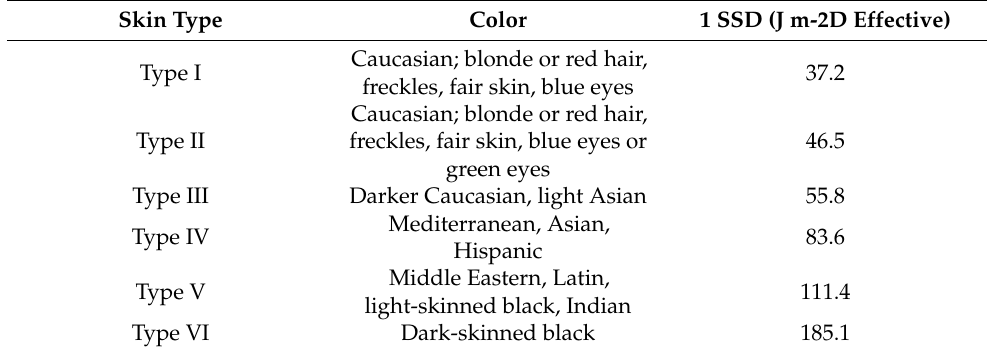
Table 2. Standard vitamin D dose